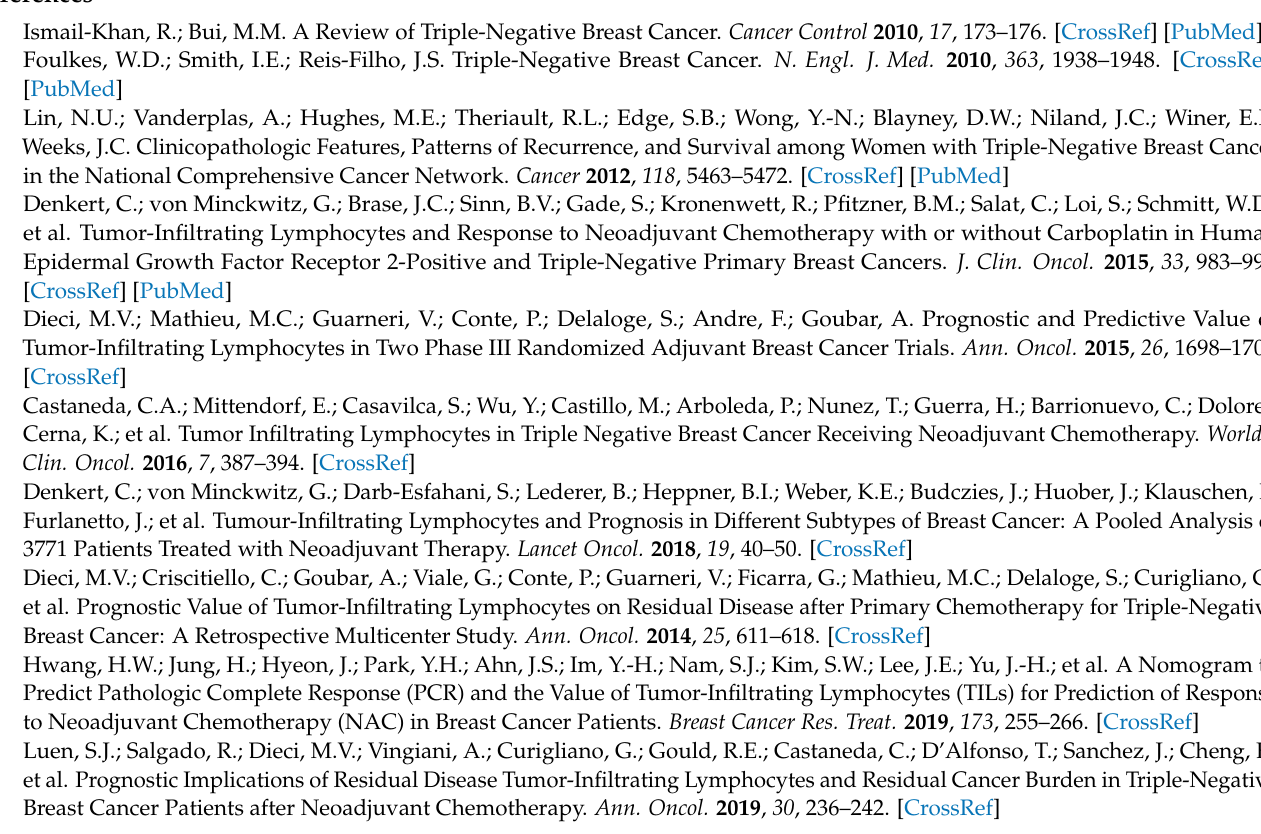
Table S7: Raw data of the full